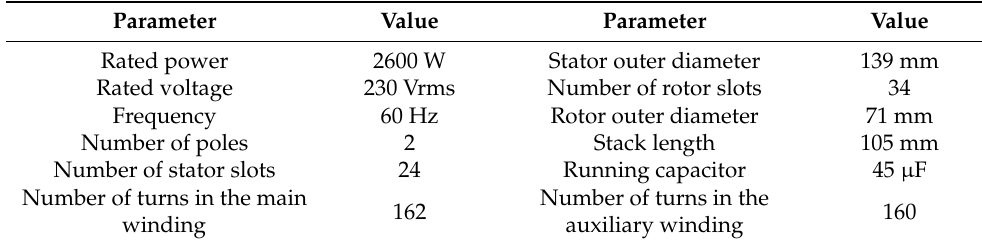
Table 1. The parameters of the capacitor-run SPIM